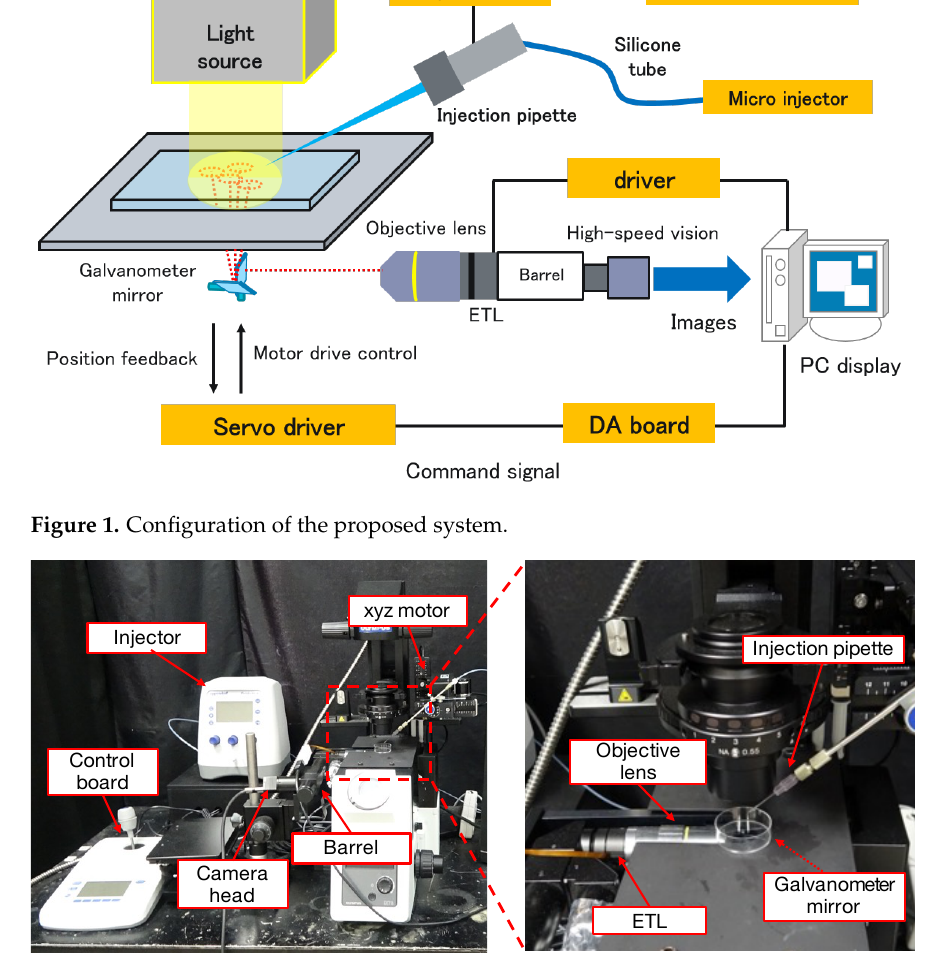
Figure 2. Overview of the proposed